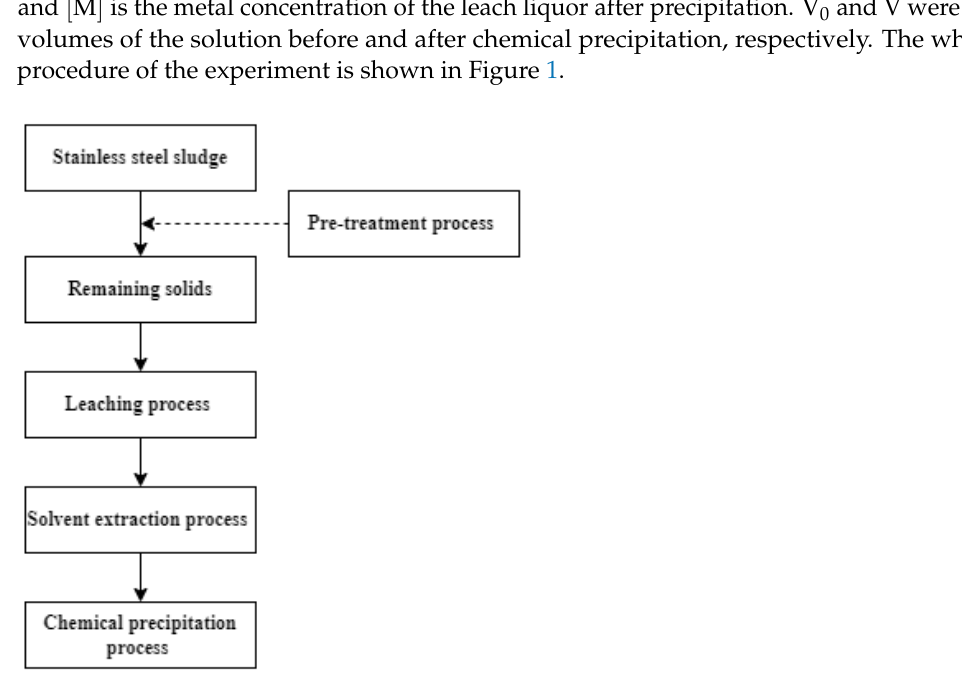
Figure 1. The outline of recovery system for iron, nickel, and chromium from stainless steel sludge.